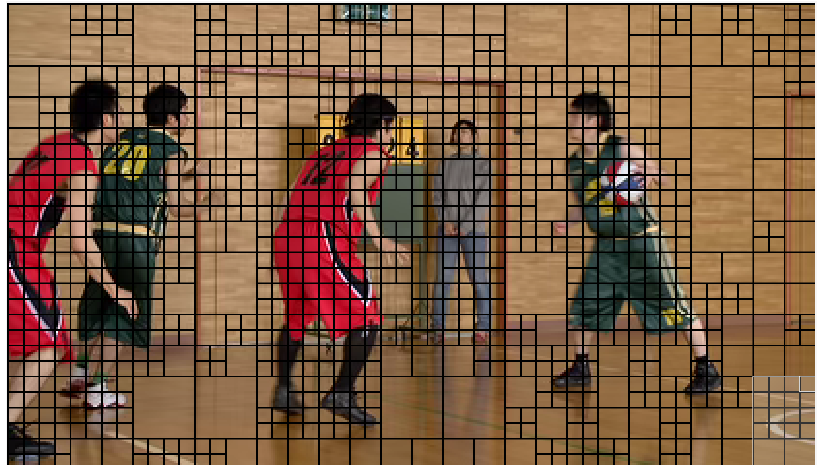
Figure 13. Partition result of the 200th frame in sequence BasketballPass, which is encoded by original HM16.7 under QP 22. Solid black line represents the partition result of